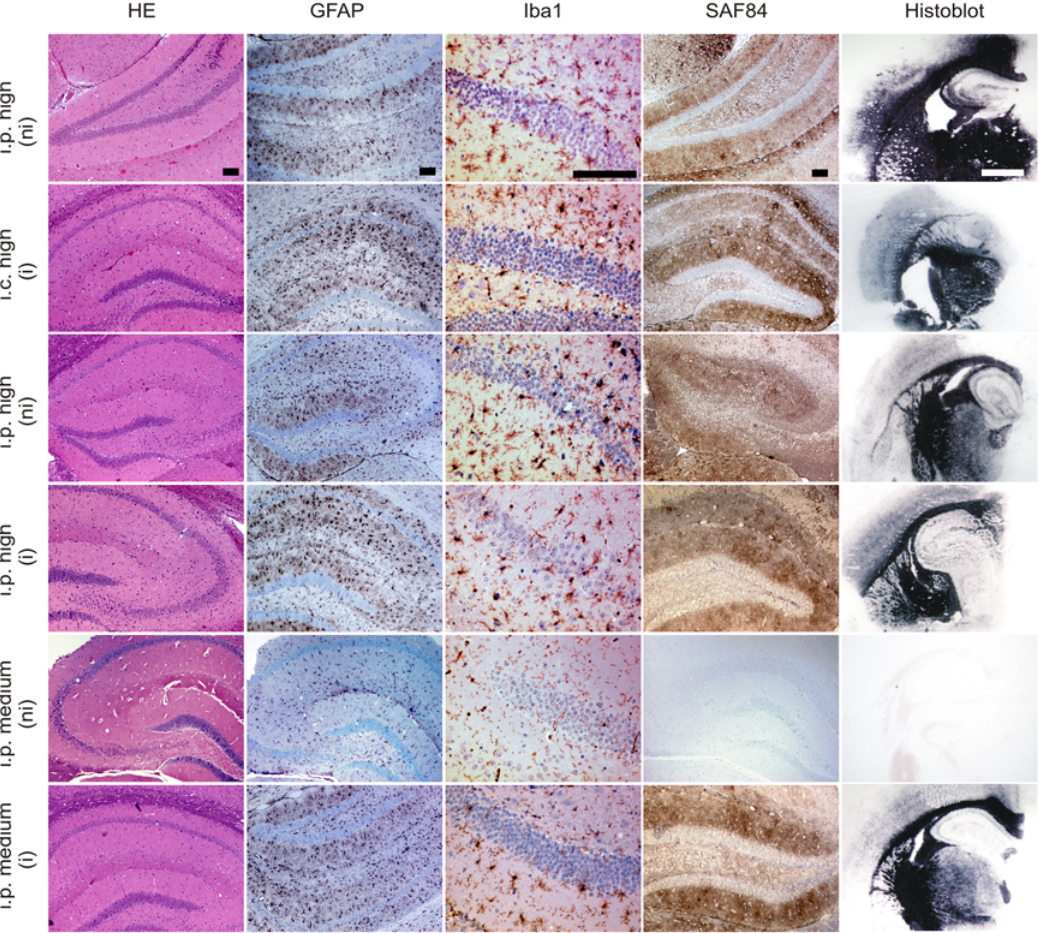
Figure 5. Brain pathology of terminally sick or asymptomatic mice. Immunized (i) and non-immunized mice (ni) inoculated intracerebrally (i.c.) or intraperitoneally (i.p.) with medium or high dose of prions were analyzed by histology. HE stains and immunohistochemistry were performed as indicated: astrocytes (GFAP), microglia (Iba1), PrP deposits (SAF84), showing astrogliosis, microglia activation, and prion protein deposition in terminally sick mice from each of the experimental groups. Histoblot analyses detected PrP Sc in the brains of all terminally sick mice with similar distribution patterns. Non-immunized mice inoculated i.p. with a medium dose of prions remained healthy up to 500 dpi, and displayed much less GFAP + astrocytes and Iba1 + microglia cells, and lacked both PrP deposits (SAF84) and PrP Sc (histoblot) at 400 dpi. Scale bars: histoblot=1 mm; histology=100 m m.